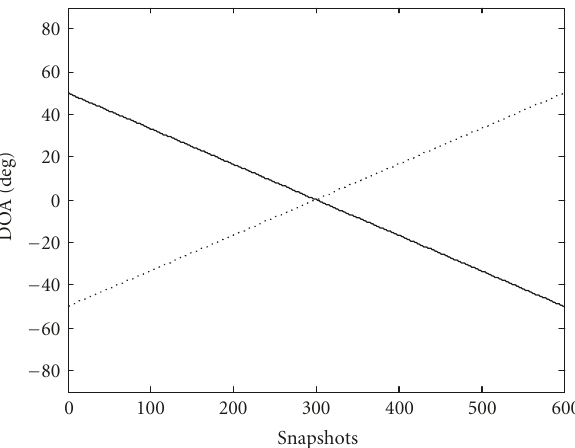
Figure 4: The trajectories of sources in the second simulation scenario.